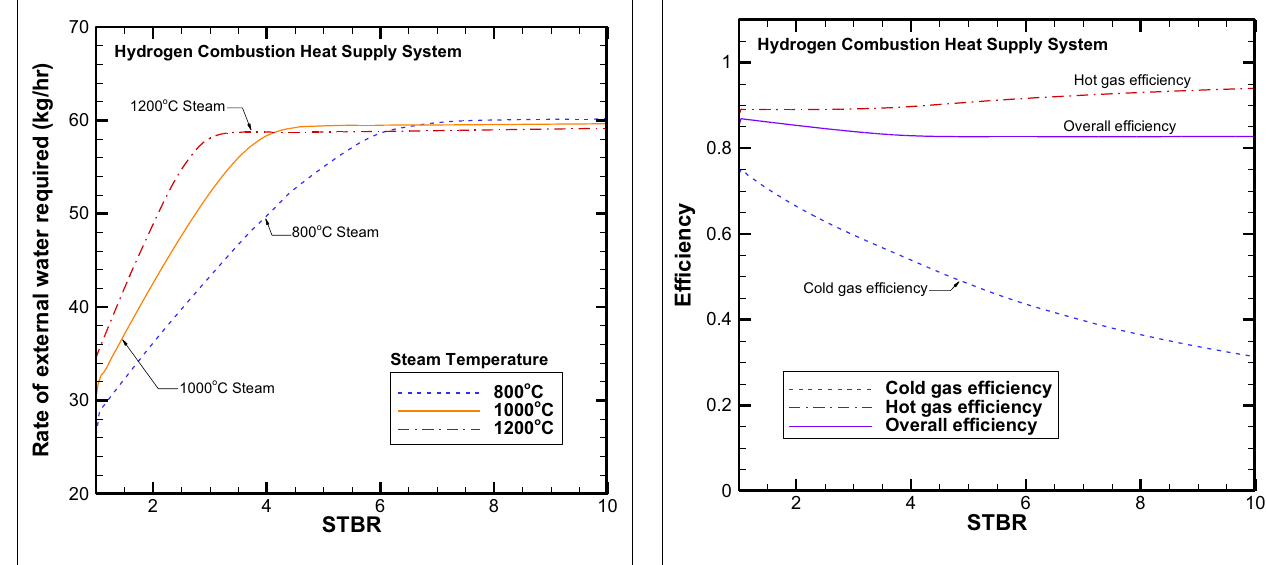
Concept system I – hydrogen combustion heat supply system.